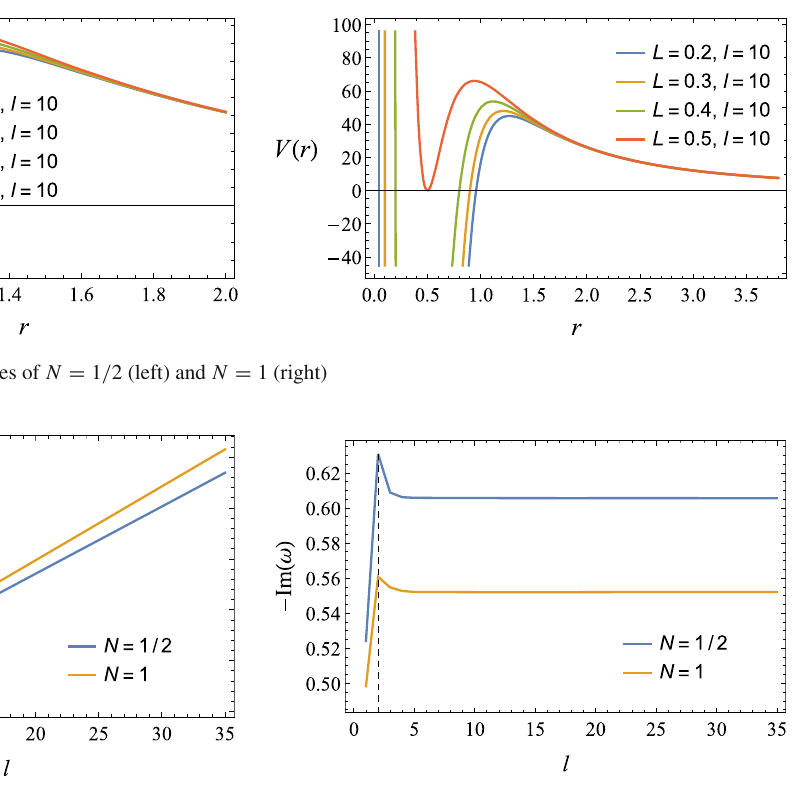
Fig. 14 QNMs with respect to l , where L = 0 . 45 and n = 0 are set. The left diagram represents the real parts of ω with respect to l for the cases of N = 1 / 2 and N = 1, respec-